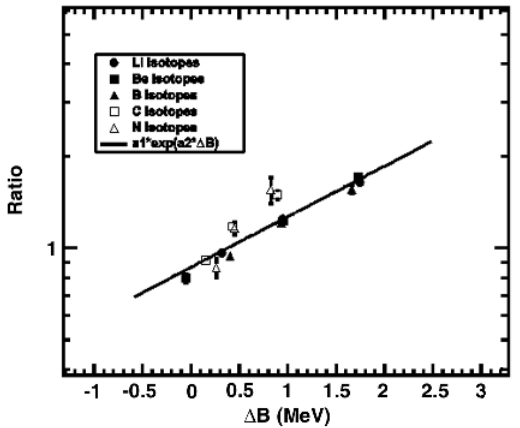
Figure 3: Scaling of experimental cluster yield ratios for 48 Ca + 124 , 112 Sn reactions at E/A=45 MeV based on ground-state binding energy differences (cf. Eq. 5). ( Z 1 = 25 , A 1 = 48) and P LF ∗ = ( Z 2 = 26 , A 2 = 49). However, this latter 2 = case corresponding to significant proton pickup and a high value T eff (5 . 5 ± 0 . 3) MeV is deemed highly unlikely, based on driving potentials and similar 40 , 48 Ca + 112 Sn experiments [25].